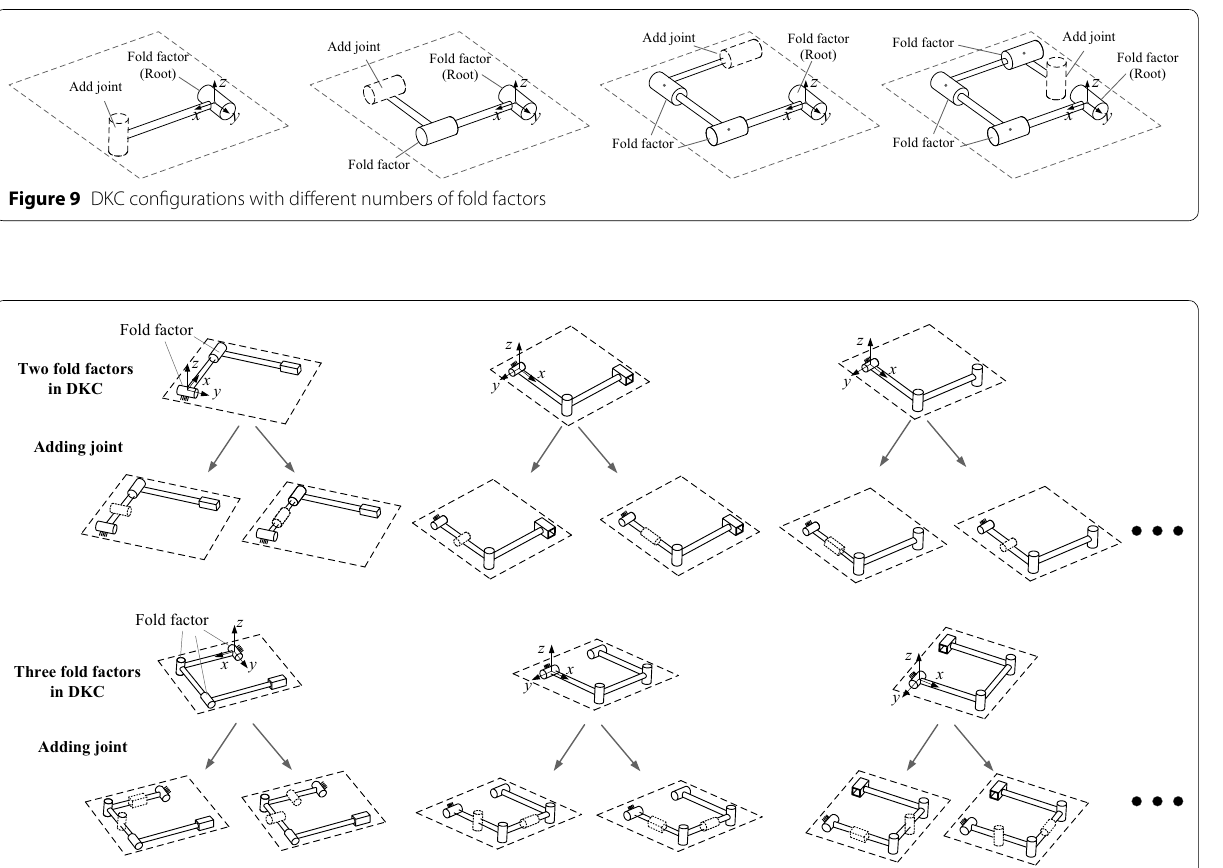
Figure 10 DKC cases with two‑ and three‑fold